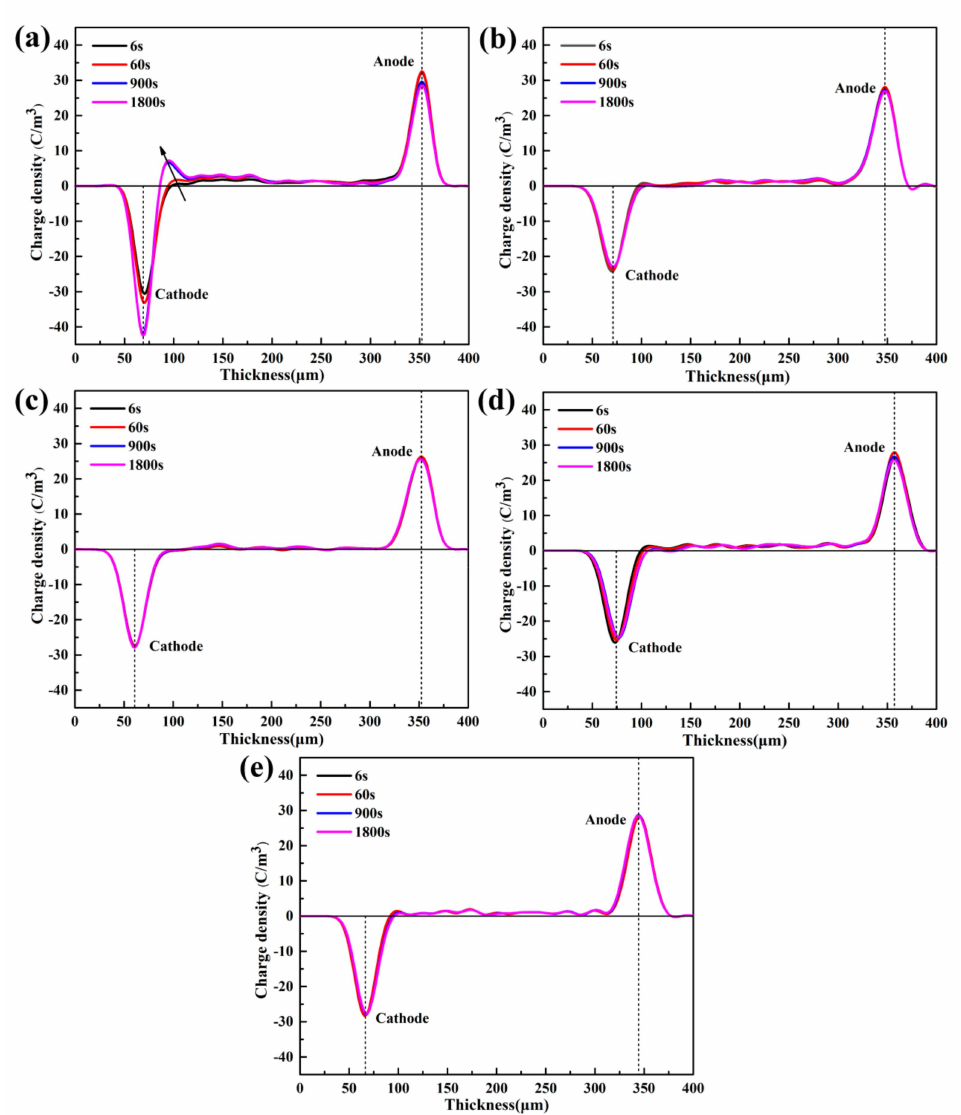
Figure 6. Space charge distributions of LDPE and h-BN / LDPE composites filled with h-BN: ( a ) 0, ( b ) 1, ( c ) 3, ( d ) 5, and ( e ) 10 phr under a polarization field of 40 kV /